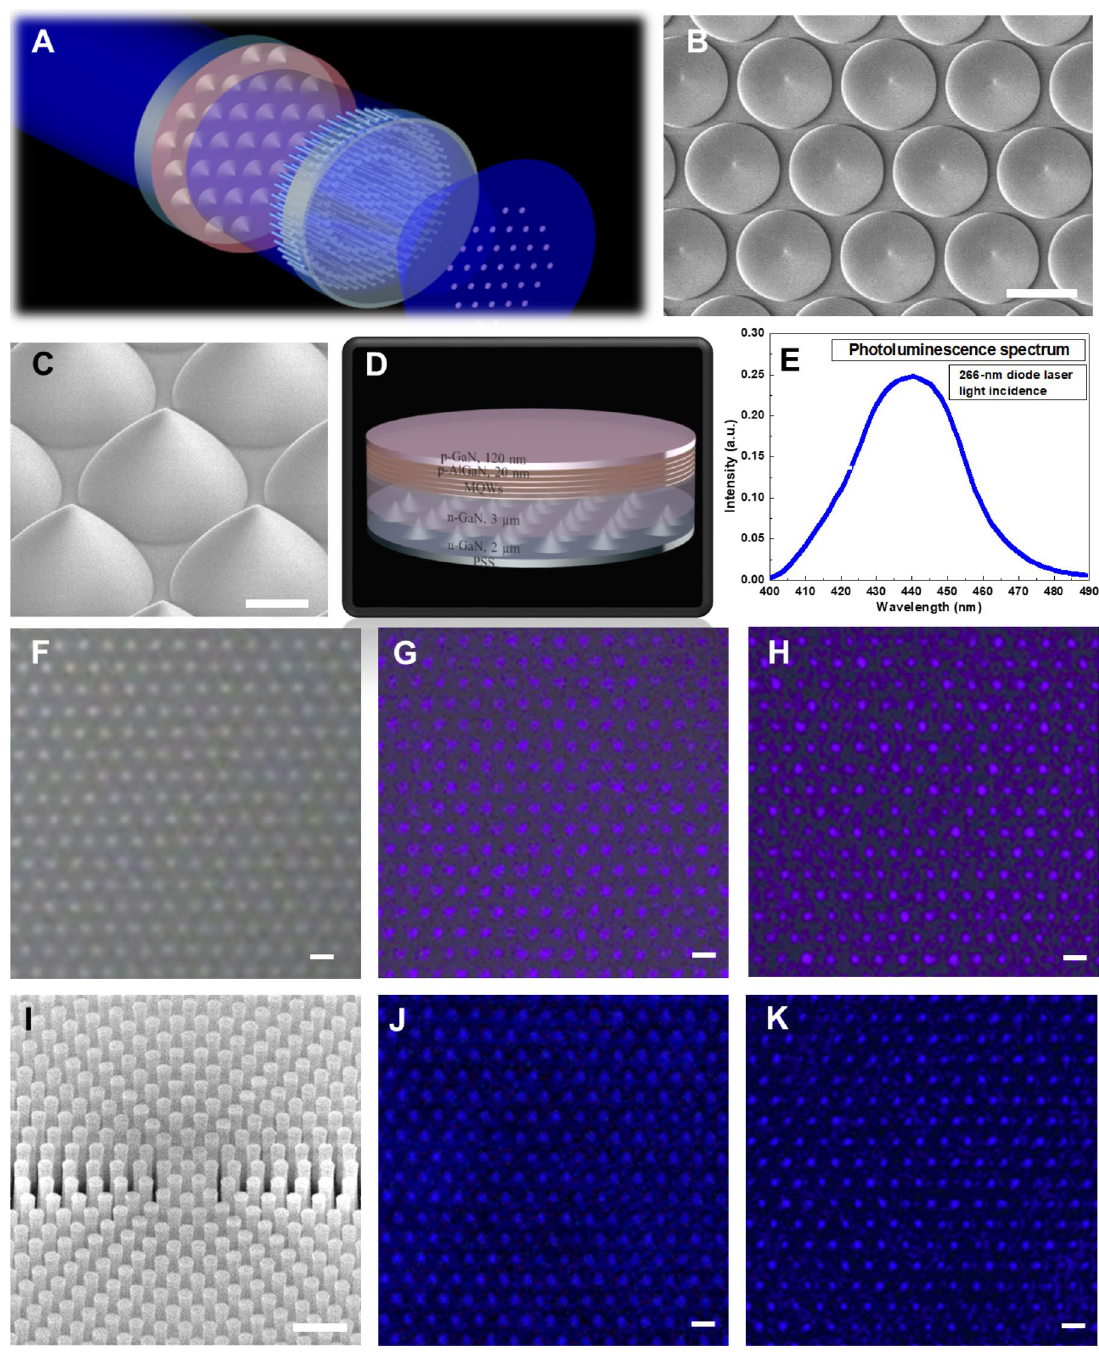
Figure 5. Imaging with the native PSS and the blue LED on the PSS. ( A ) Schematic of patterned structures inspected by the metalens. ( B ) The top-view SEM micrograph of the native PSS. Scale bar: 2 μm. ( C ) The tilt-view SEM micrograph of the PSS. Scale bar: 1 μm. ( D )The epitaxial structures of the blue LED. ( E ) Photoluminescence spectrum. Images of the PSS formed by the objective lens (NA = 0.4) with the incidences of ( F ) the halogen lamp and ( G ) the 405-nm laser light. ( H ) PSS Image formed by the 405-nm-designed metalens (NA = 0.3) at the laser wavelength of 405 nm. Scale bar, 3 μm in ( F – H ). ( I ) The tilt-view SEM micrograph of the fabricated metalens designed at the wavelength of 450 nm. Scale bar: 500 nm. Images of the PSS on which the blue LED taken by ( J ) the objective lens (NA = 0.4) at the laser wavelength of 450 nm, and ( K ) the 450-nm-designed metalens (NA = 0.3) at the laser wavelength of 450 nm. Scale bar, 3 μm in ( J , K